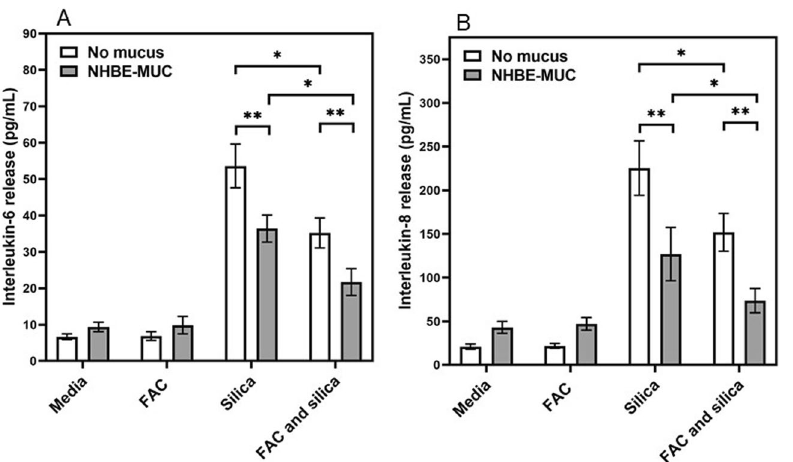
Figure 8. Release of inflammatory mediators after exposures to iron, mucus, and silica. While silica increased cell release of IL-6 ( A ) and IL-8 ( B ), iron and mucus both decreased these levels. One way ANOVA was employed. *Decreased relative to silica without iron (p < 0.05); **decreased relative to without mucus (p <